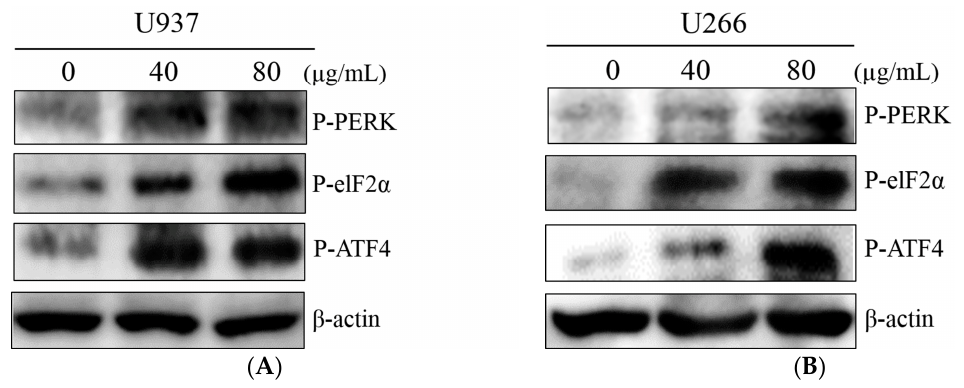
Figure 2. The effect of COM on ER stress-related proteins in U937 and U266 cells. ( A ) U937 cells were treated with COM (40 or 80 µg/mL) for 24 h, and Western blot analysis was performed for P-PERK, P-eIF2 α , P-ATF4, and β -actin; ( B ) U266 cells treated under the same conditions.